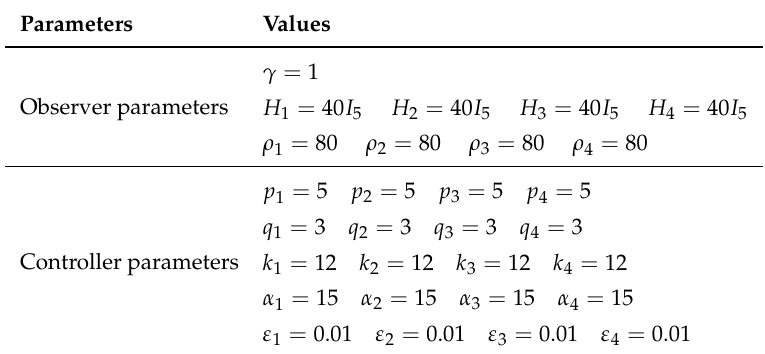
Table 2. Parameters used in the proposed method in a four-area interconnected power system.